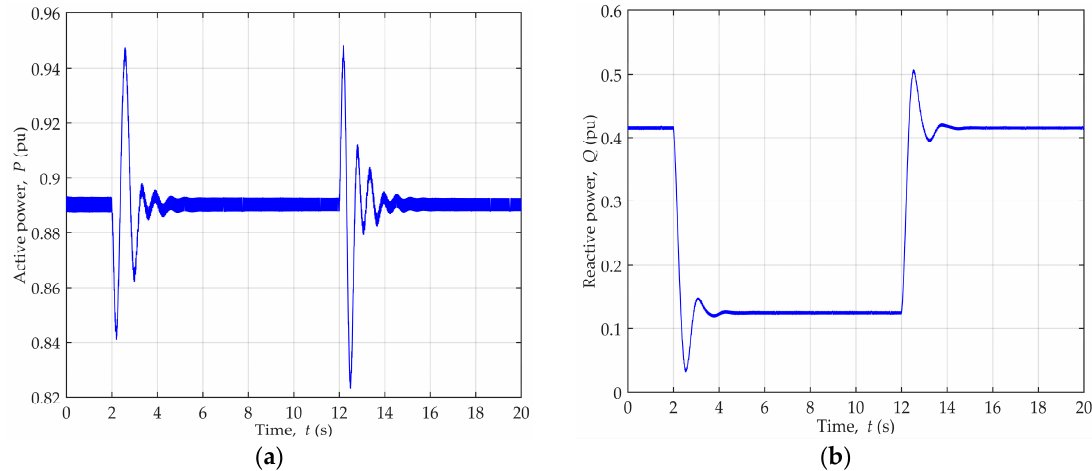
Figure 5. Generator power change during dynamic disturbances of reactive power for generator operating point P = 0.89, Q = 0.41 ind.: ( a ) Active power; ( b ) Reactive power.